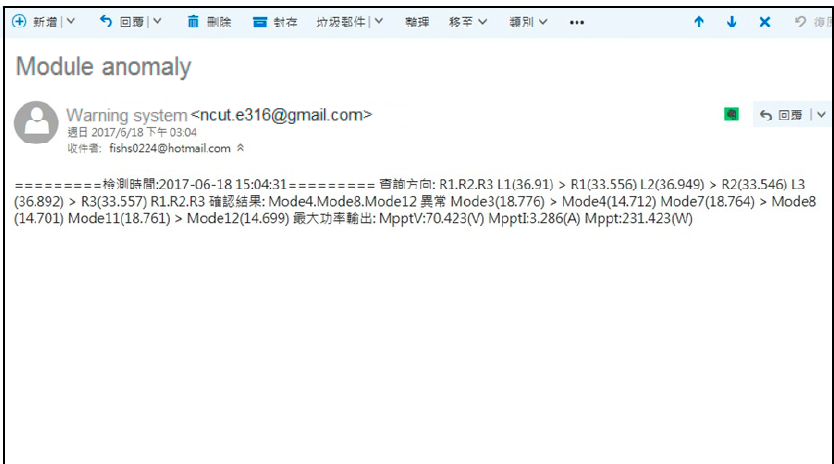
Figure 8. Actual detection status of the fault diagnosis software interface.